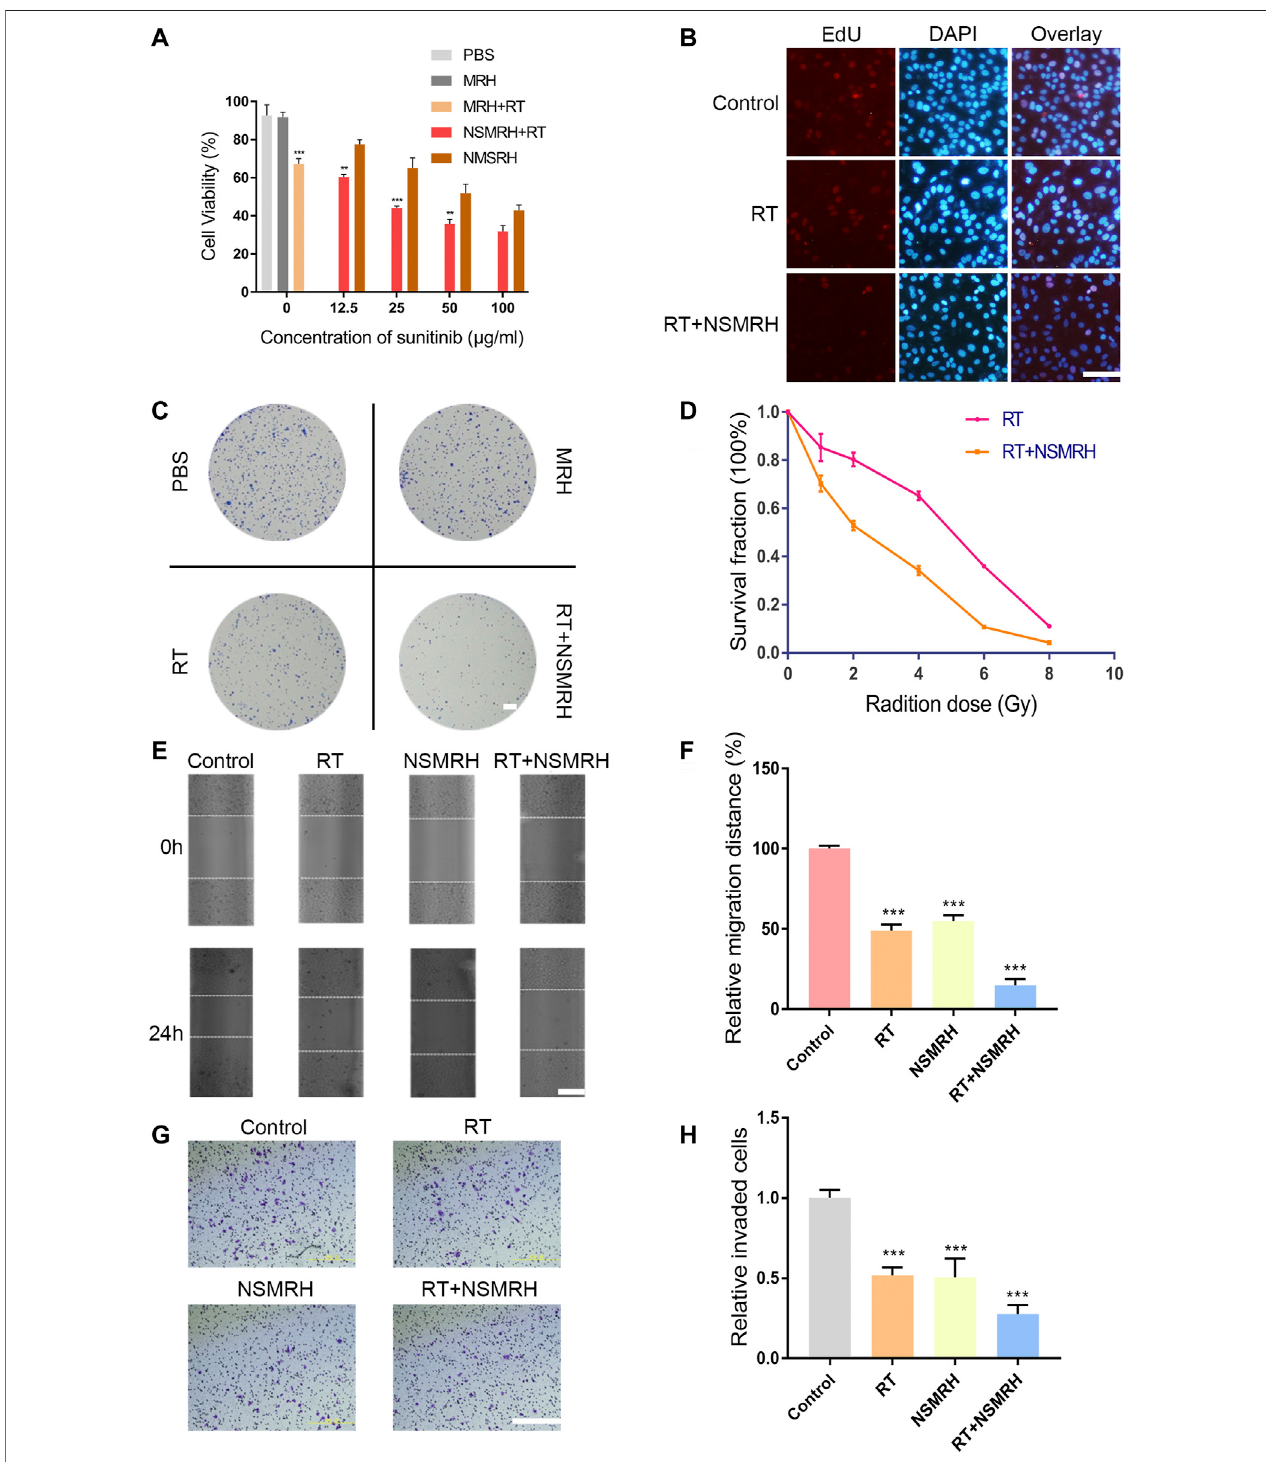
FIGURE 3 | In vitro functions of NSMRH in MM-231 cells. (A) Effects of different conditions on MM-231 cells viability at 48 h. (B) Edu staining of MM-231 cells, red fl uorescence represents proliferating cells, scale bars: 100 μ m. (C) A clonogenic assay was performed. Colonies larger than 50 cells were counted, and phase-contrast images were taken, scale bar: 2.5 mm. (D) Survival curves of MM-231 cells exposed to increased irradiation. (E) Effect of NSMRH on MM-231 cells migration. Representative images showing tumor cells migration, scale bars: 100 μ m. (F) The fi gure shows quantitative analysis of a wound healing assay, with triplicate measurements of three independent experiments. (G) Photomicrographs illustrate representative fi elds of invaded cells, scale bars: 100 μ m. (H) The relative number of invaded cells was calculated, and the data are presented in a histogram from three independent experiments.